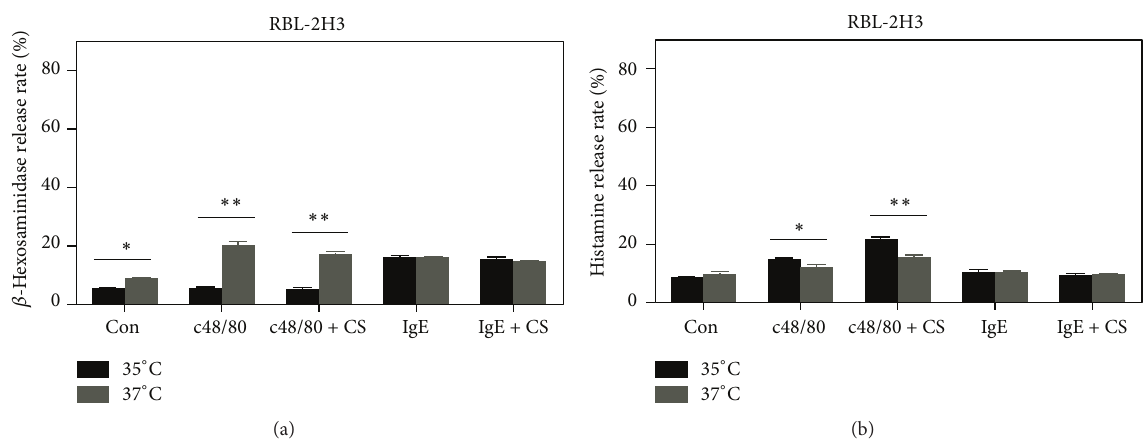
Figure 5: The effect of temperature on RBL-2H3 degranulation. RBL-2H3 cells were left untreated (Con) or treated by either c48/80 or a combination of IgE and anti-IgE. In some experiments, cells were activated in the presence of the mast cell stabilizer cromolyn sodium (CS). 𝛽 -Hexosaminidase (a) and histamine (b) release was measured. 𝛽 -Hexosaminidase or histamine release is expressed as percent of the total (the means ± SE, 𝑛 = 4 , representing at least three separate experiments). ∗ 𝑃 < 0.05 ; ∗∗ 𝑃 < 0.01